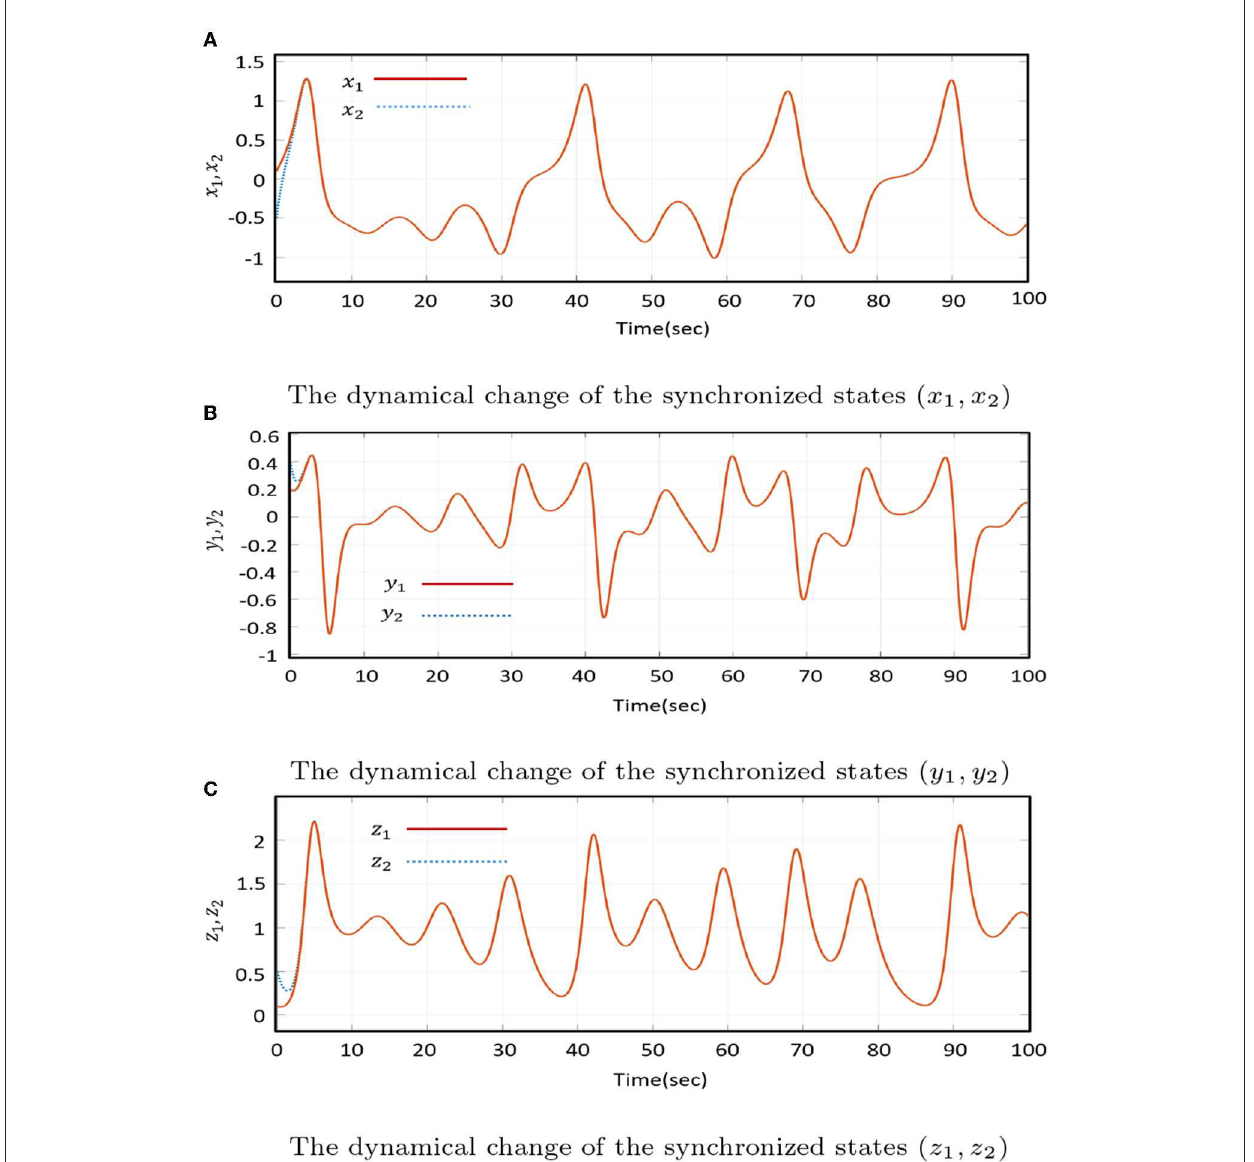
FIGURE7 The dynamical change of the states x , y , z after synchronization. (A) The dynamical change of the synchronized states ( x 1 , x 2 ). (B) The dynamical change of the synchronized states ( y 1 , y 2 ). (C) The dynamical change of the synchronized states ( z 1 , z 2 ).